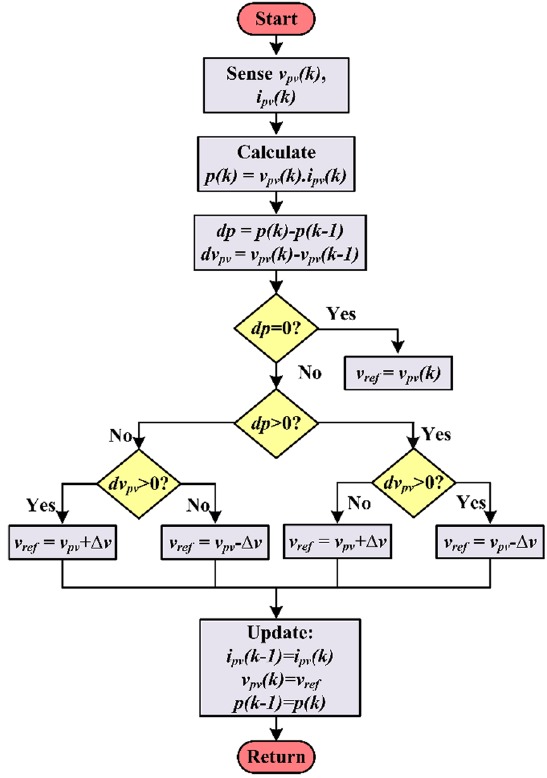
Fig. 10 Flowchart for generating the reference